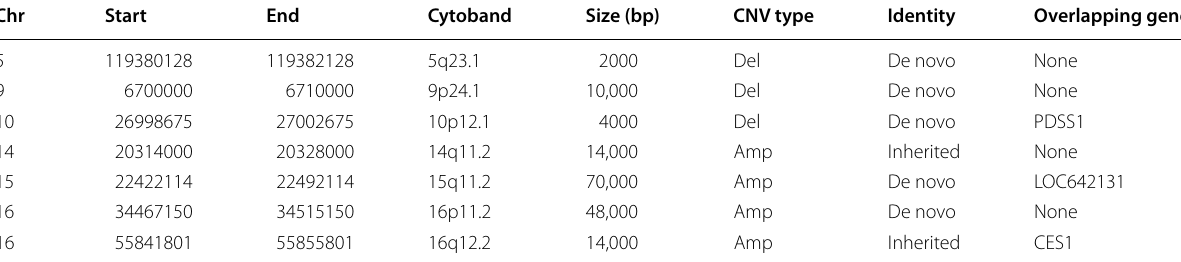
The parental sequences have been used to establish the de novo [absent in parent(s)] or inherited [also present in parent(s)] nature of each CNV. Shared identity is based on a 50% reciprocal overlap rule